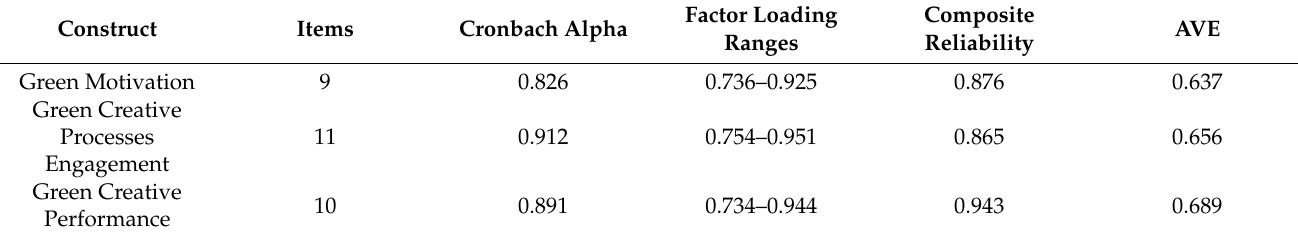
Table 2. Reliability and validity of the